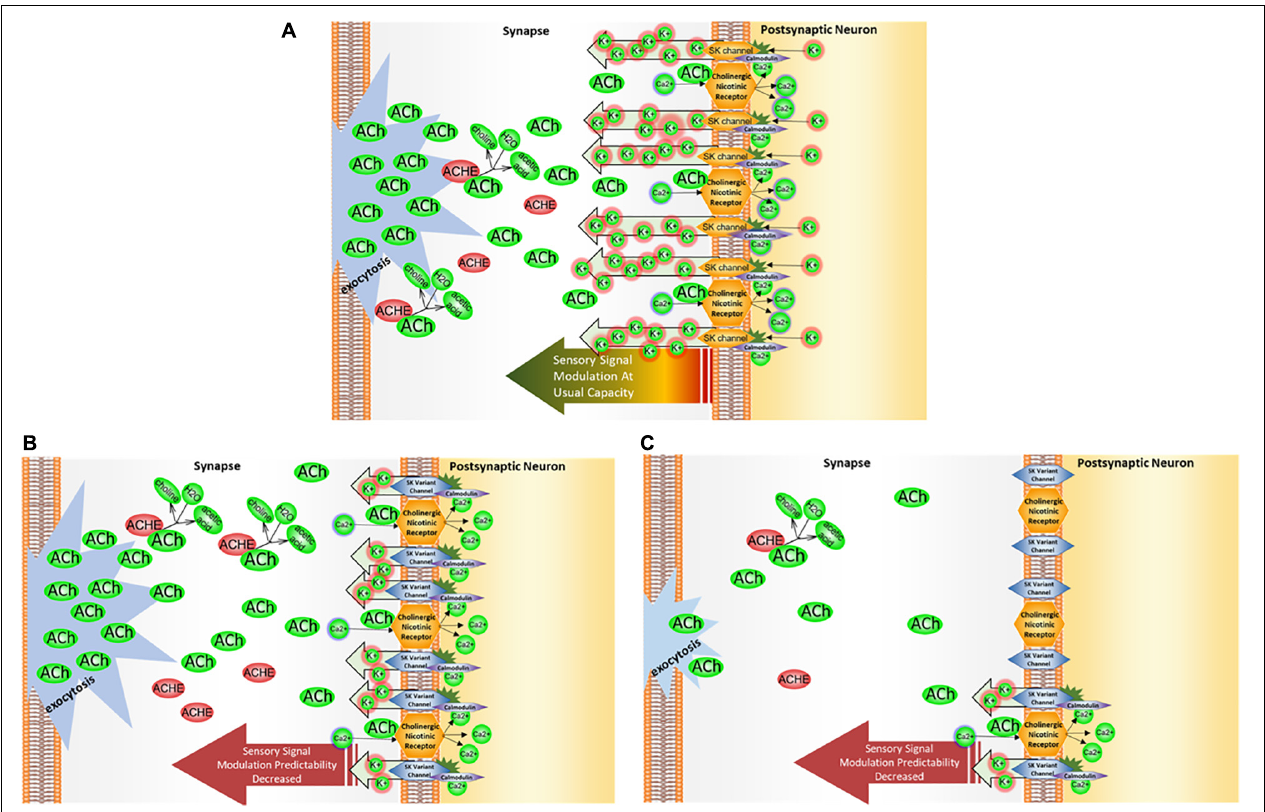
FIGURE 7 | KCNN2/ SK2 impact on cholinergic signal modulation. (A) SK2 channel operation. SK2 channels operate in tandem with a propagation of cholinergic signal as they counter the membrane depolarization brought about by calcium influx through cholinergic receptors. The calcium influx activates the calmodulin domains on SK2 channels, permitting passage of potassium back into the synapse to restore membrane hyperpolarization. Thus, SK2 channels serve a critical role in helping a neuron to recover and re-hyperpolarize before receiving the next cholinergic signal. (B) In the presence of KCNN2 /SK2 variant. When SK2 channel binding activity and/or functionality is altered, the sensory signaling modulation could either be too efficient —that is, the membrane repolarizes too soon due to overflow of K + ions back into the synapse, or not efficient enough , with membrane taking too long to repolarize, leaving the neuron less ready to process any